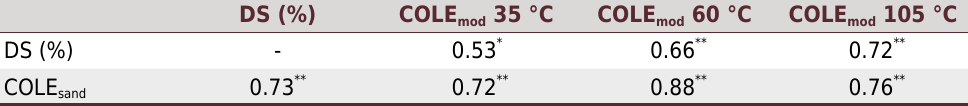
Table 3. Pearson correlation between the degree of shrinkage (DS), modified coefficient of linear extensibility (COLE mod ), and coefficient of linear extensibility obtained by the “Ring with Sand Method” (COLE sand ) DS (%) COLE sand temperatures, method proposed by Schafer and Singer (1976). DS: obtained by the Metallic Mercury